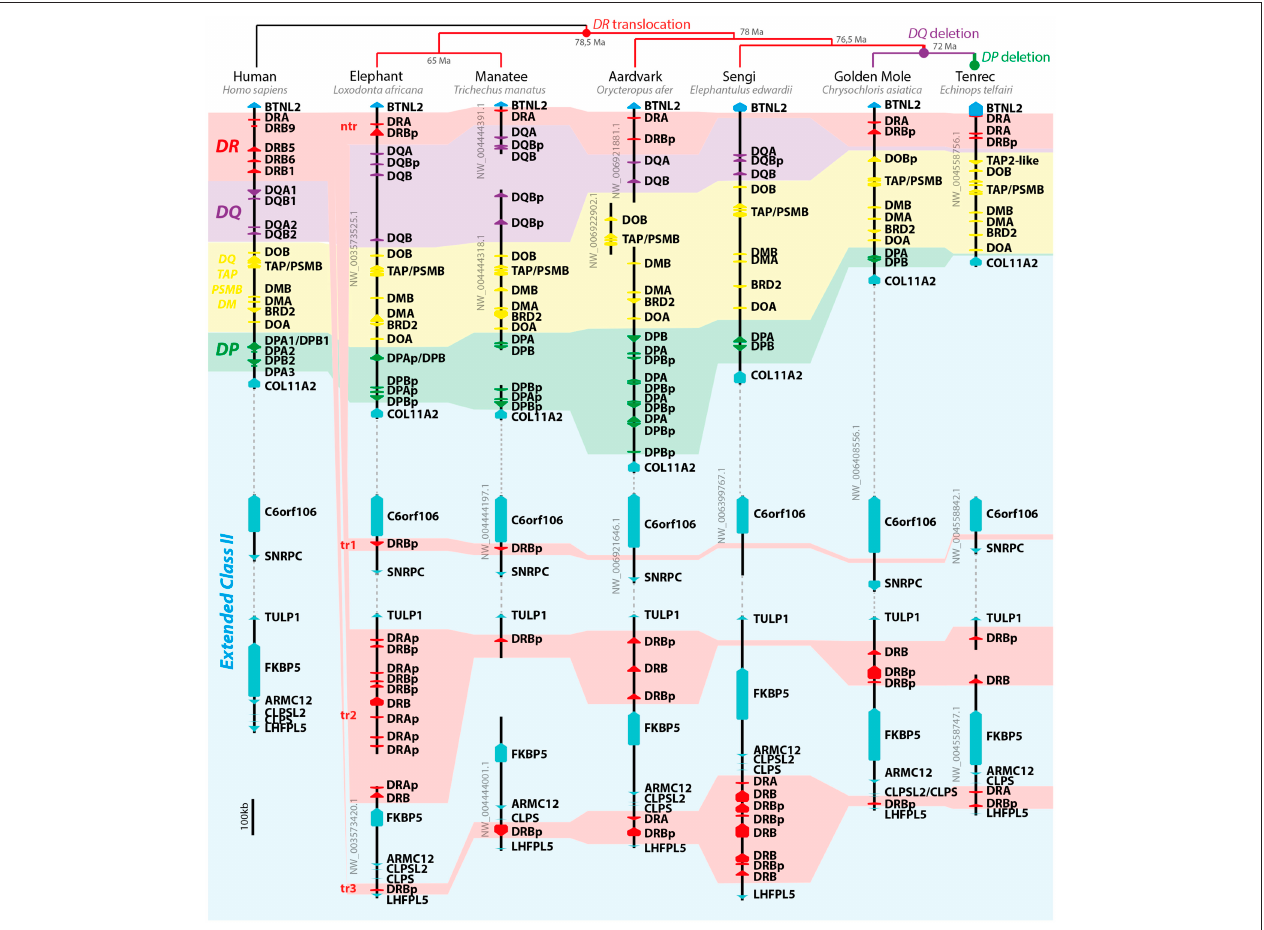
FIGURE 2 | Model of afrotherian class II MHC evolution. On the top of image, the afrotherian phylogeny and divergence time (Ma, million years before present) proposed by Springer et al. ( 39) and presumptive evolutionary events leading to current afrotherian MHC structure. On the left the human class II MHC region is depicted as an outgroup and model of the mammalian genome organization. Dashed lines represent regions of the scaffolds excluded for clarity purposes, which are not to scale. Arrows represent genes and pseudogenes (shown as “p” in the end of the gene’s name). Only informative scaffolds of the MHC structure are displayed. In color, a schematic view of class II loci helps to understand the evolution of class II loci ( DR —red; DQ —purple; DP —green; DO/TAP/PSMB/DM —yellow). TAP/PSMB represents TAP1 , TAP2 , PSMB8 , PSMB9